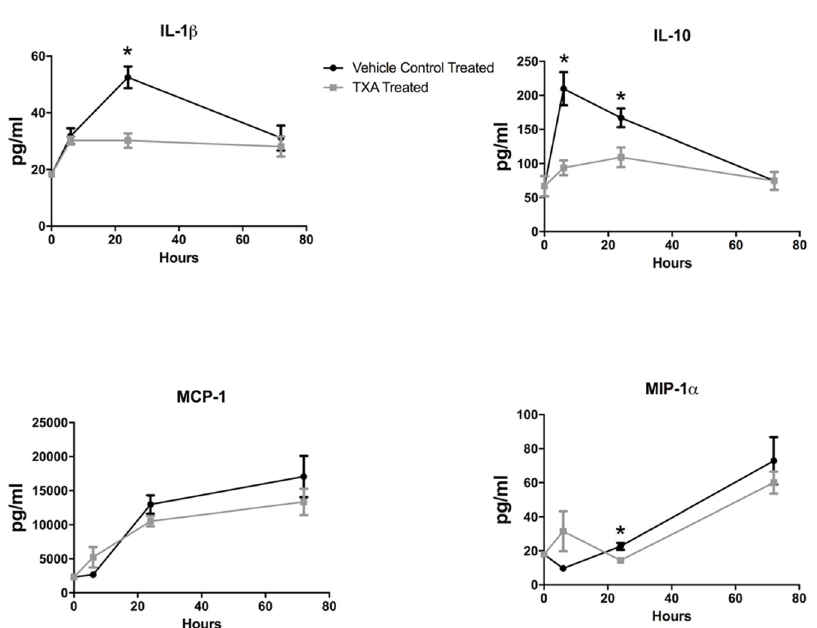
Fig 4. Expression of serum inflammatory cytokines in rats subjected to controlled hemorrhagic shock and resuscitation, vehicle control (normal saline) treated vs. tranexamic acid (TXA) treated, 300mg/kg ( � p < 0.05, error bars =